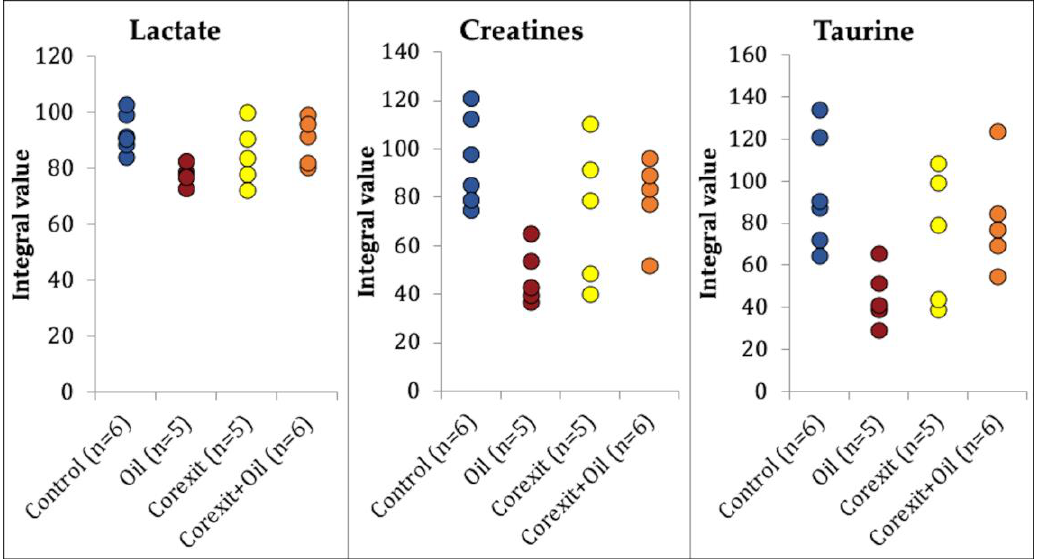
Figure 3. Individual value plots of the normalized and weighted integrals of lactate, creatines, and taurine from the aqueous extracts of hatchling loggerhead sea turtle ( Caretta caretta ) skeletal muscle. Integral values are analogous to metabolite concentration. Treatment groups are labeled on the x axis. Lactate, creatines, and taurine concentrations were significantly different among treatment groups (Kruskal Wallis tests: p = 0.020, p = 0.016, p = 0.028, respectively, α = 0.05). Post hoc Dunn’s all -pairwise comparisons tests showed that control and crude oil groups were significantly different from each other in lactate, creatines, and